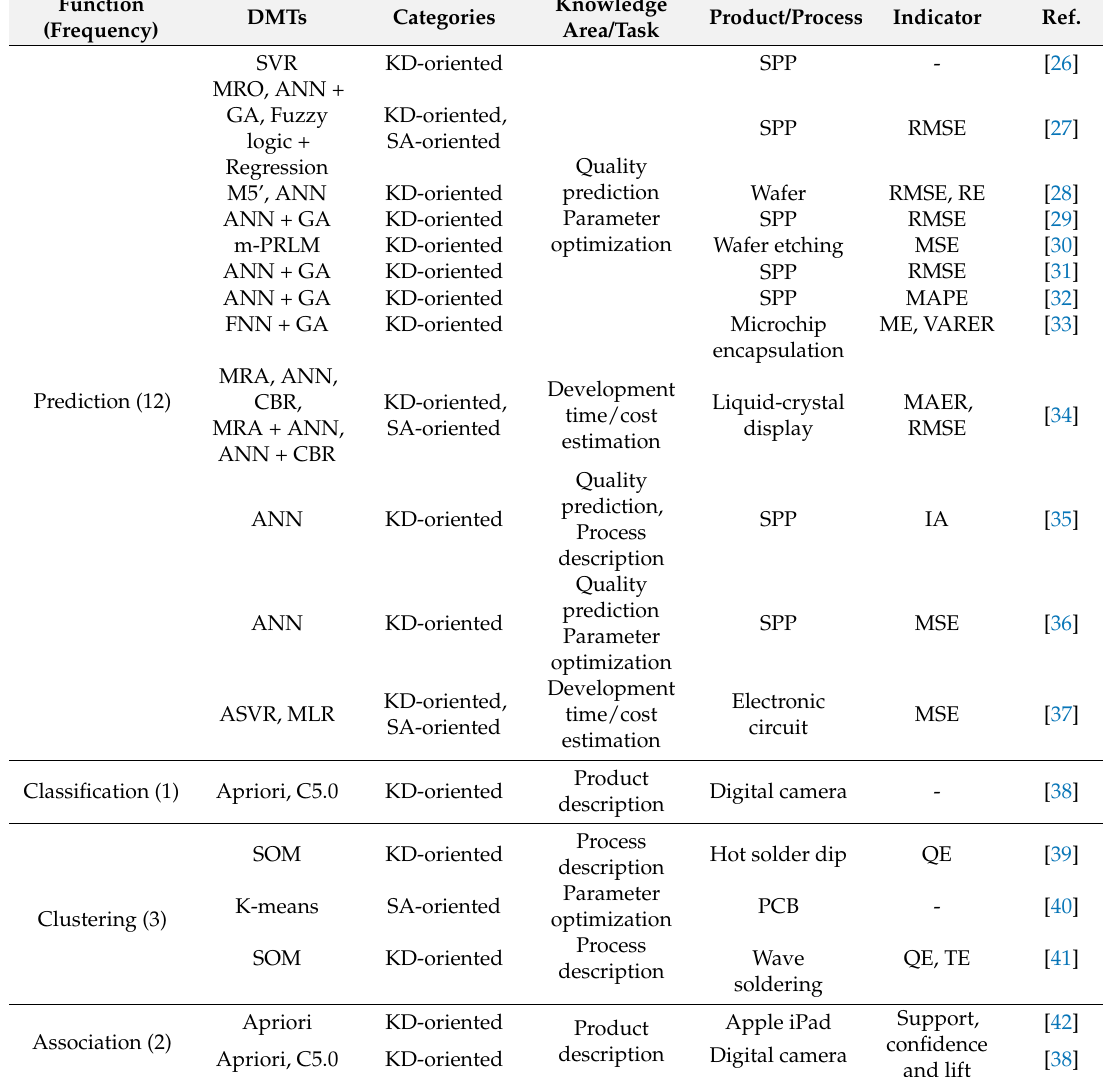
Table 9. DM with Big Data application in the design